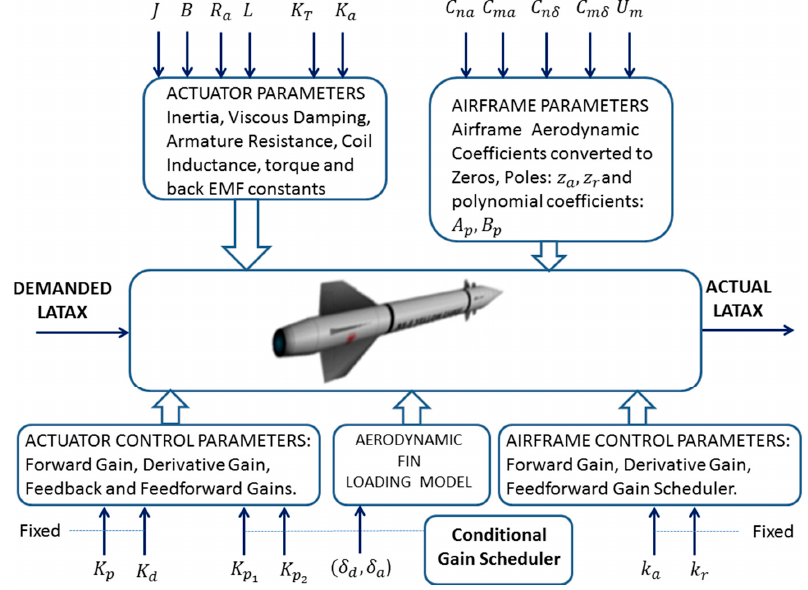
Figure 7. System parameterization.